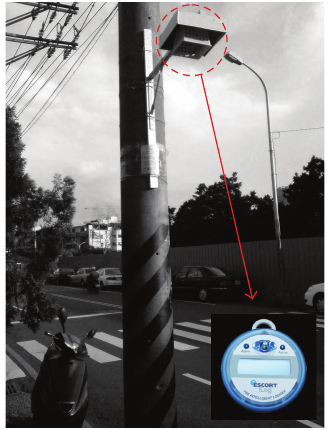
Figure 2: Installation of temperature/humidity data logger at a selected site.